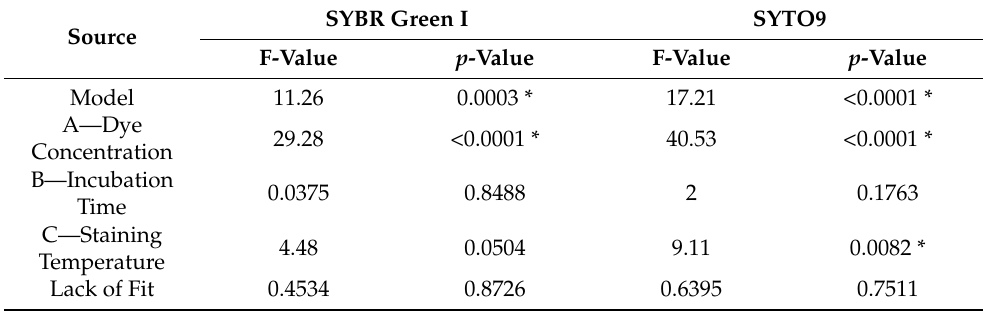
Table 4. ANOVA, p -values and F- values of the parameters up to a cell damaging response.